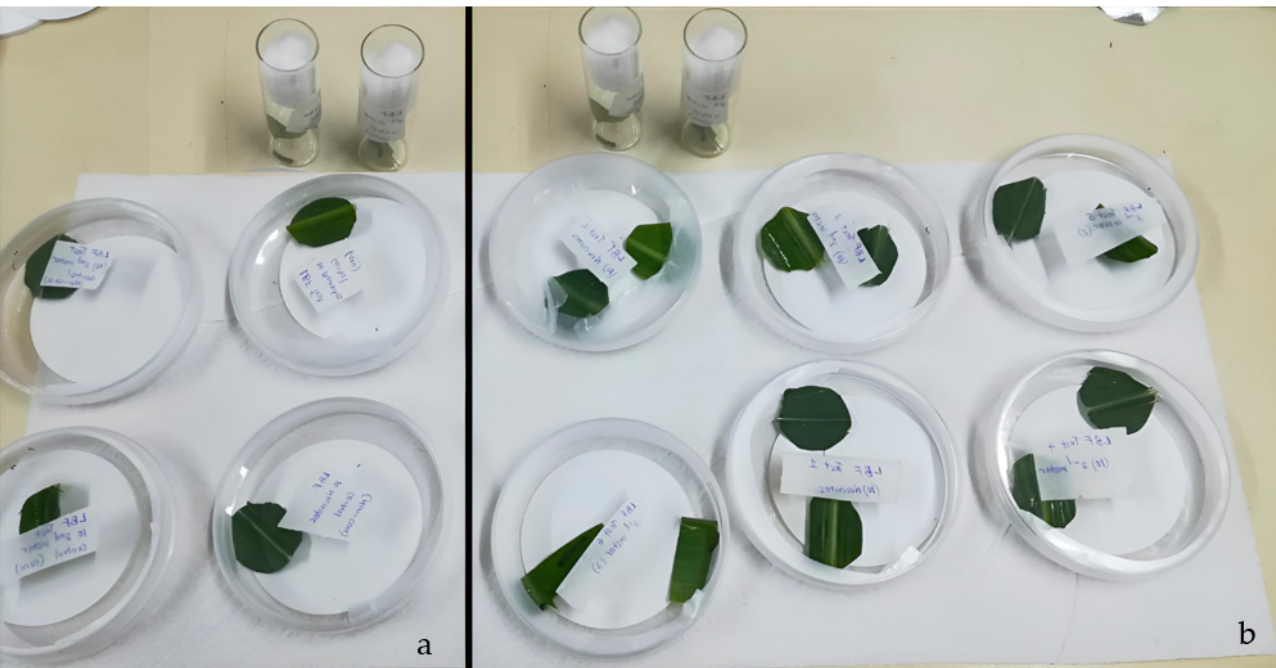
Figure 1. Experimental set-up for ( a ) no-choice experiment and ( b ) two-choice experiment for larval arrestment and settlement assessment.